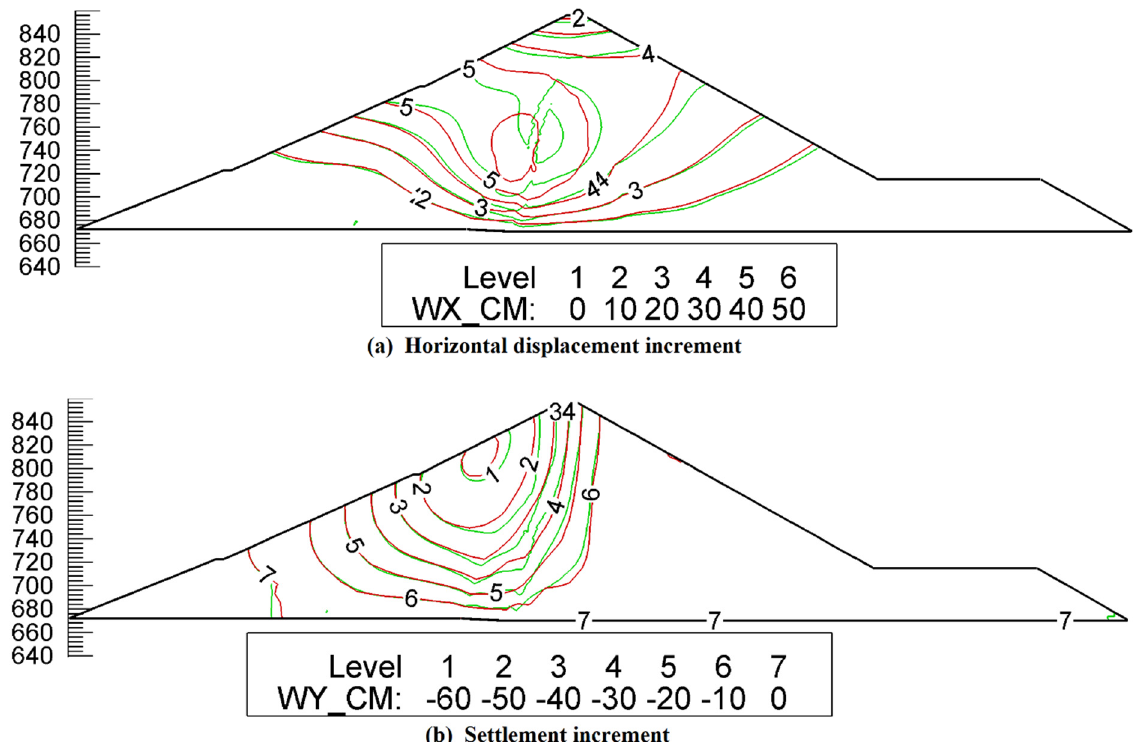
Figure 12. The displacement increment caused by impoundment.